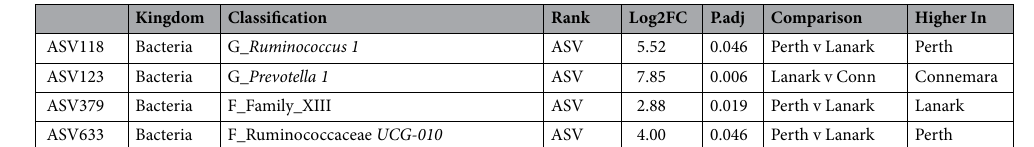
Table 5. Differential abundance analysis investigating the pairwise differences in bacterial and archaeal abundances between each of the breeds (i.e. Cheviot, Connemara, Lanark and Perth) in solid, liquid and epithelial ruminal fractions. Analysis was conducted across all taxonomic ranks for bacterial populations (Phylum, Class, Order, Family, Genus and ASV), and lower taxonomic ranks for archaeal populations (Genus and ASV) using the Wald’s pairwise test from DESeq2. Table reports the log10 of normalised counts (Mean ± Sd), BH adjusted P values, Log2 fold change, taxonomic rank and classification, breeds compared and the breed the abundance was increased in for significant findings. Solid (Cheviot n = 8, Connemara n = 5, Lanark n = 9, Perth n = 7), liquid (Cheviot n = 9, Connemara n = 5, Lanark n = 9, Perth n = 5), epithelial (Cheviot n = 9, Connemara n = 3, Lanark n = 6, Perth n =